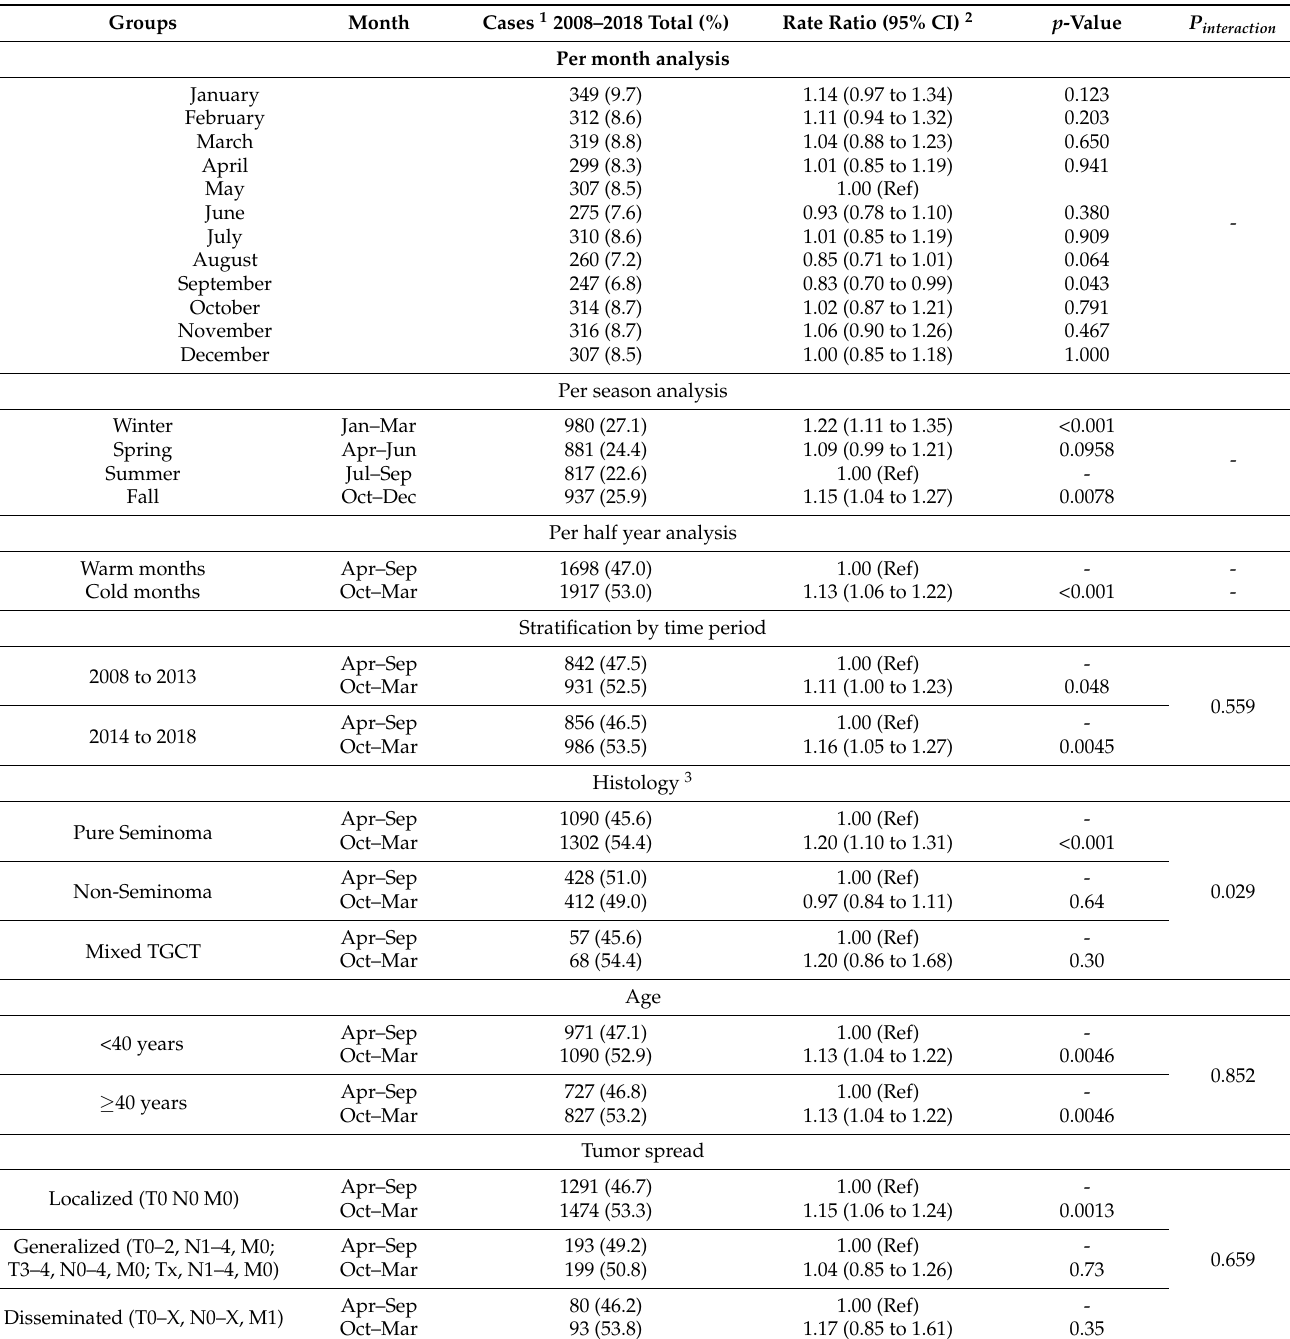
Table 1. Quasi-Poisson regression models for the number of TGCT diagnoses by month of diagnosis, season, half year and histopathological